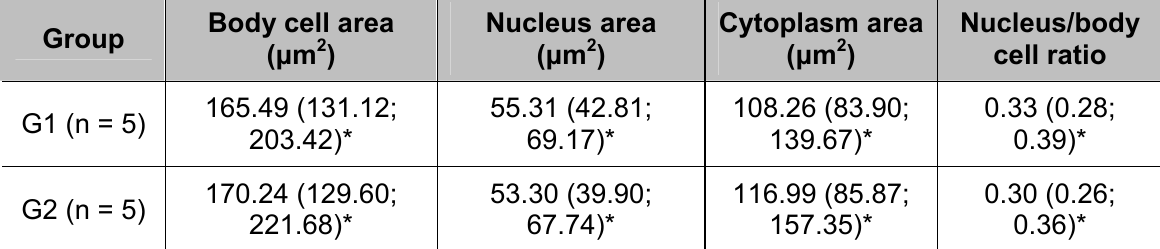
Values with asterisk in the same column present statistically significant difference (p <